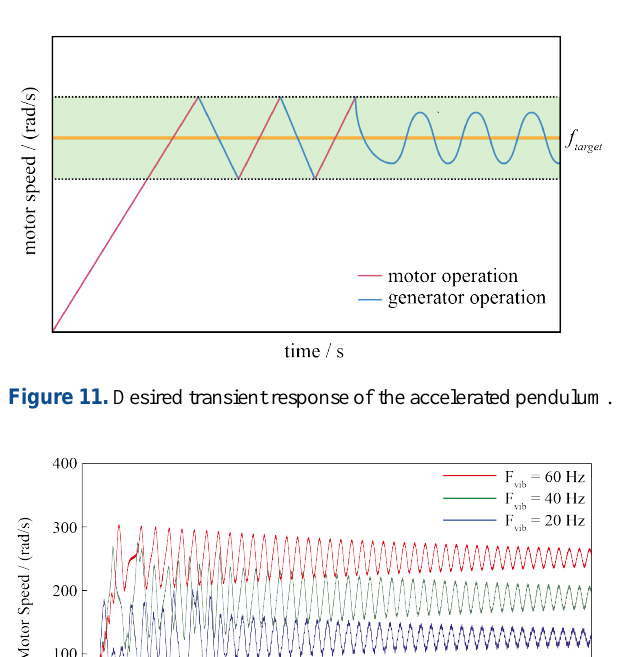
Figure 12. Simulated motor speed with respect to frequency and time.